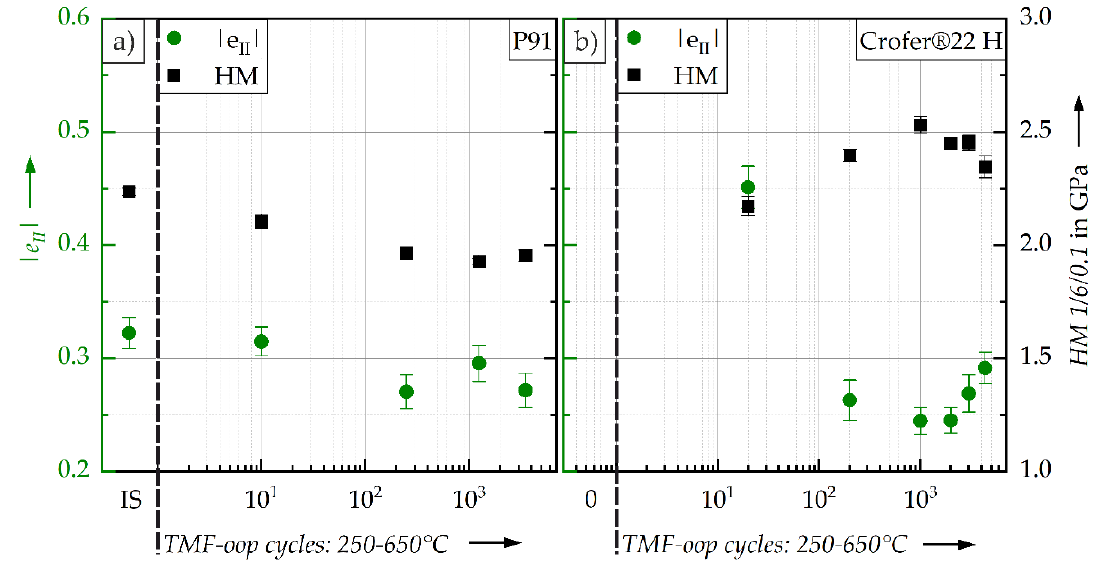
Figure 5. Cyclic hardening exponent CHT | e II | and martens hardness HM of the initial state (IS) and subject to TMF-cycles for ( a ) P91 and ( b ) Crofer ® 22 H.